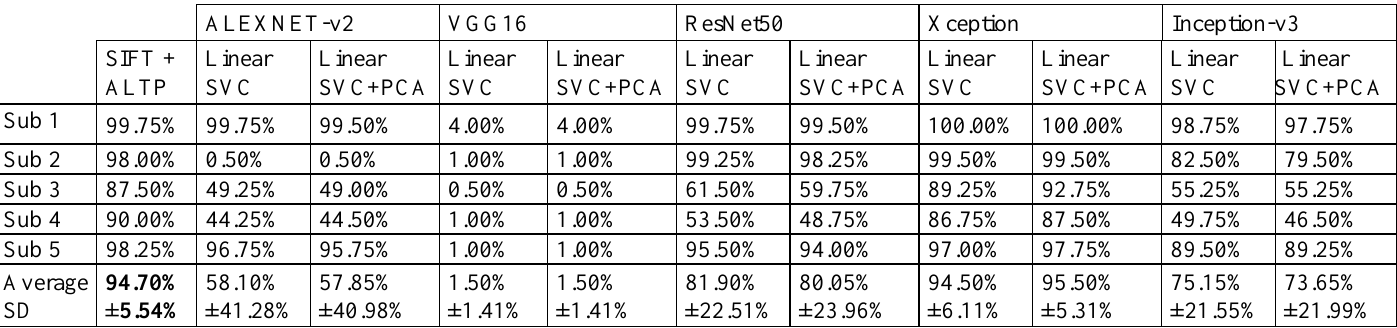
Table 6. Recognition accuracy ratio of SIFT + ALTP method and different deep learning models on the FERET database.